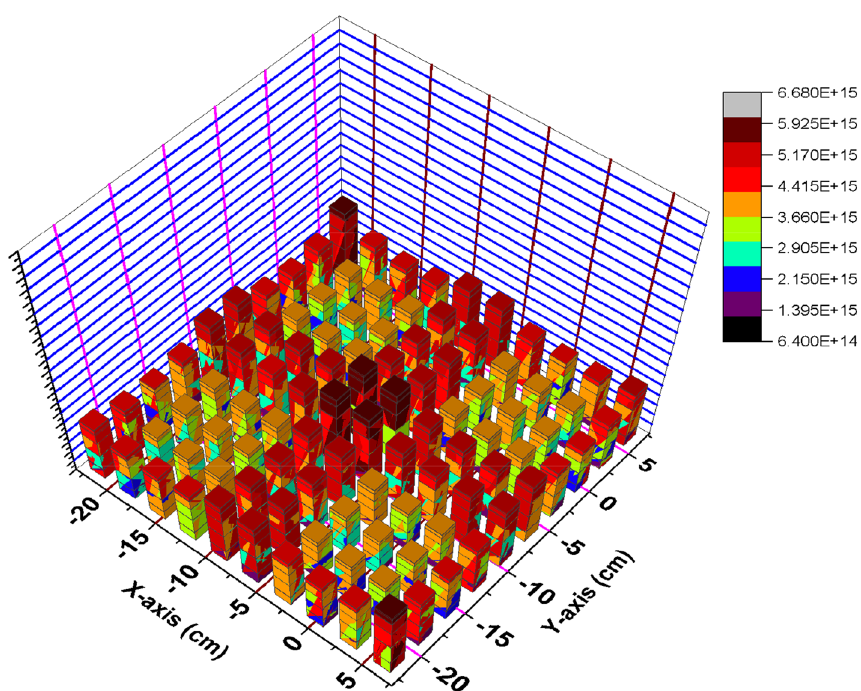
Figure 23. Thermal flux distribution at 70 GWd/ton for the C